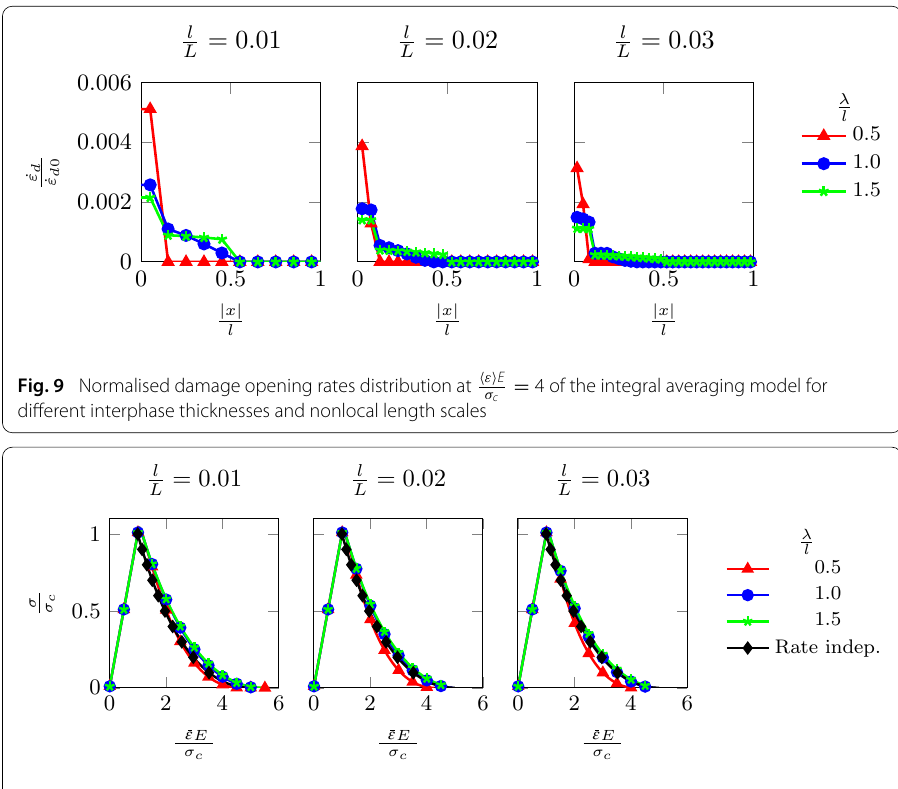
Fig. 10 The overall stress-strain response of the gradient damage model for different interphase band thicknesses and nonlocal length scales the applied average strain ¯ ε for all cases considered. Also shown (in black) is the underlying rate-independent response as given (analytically) by Eq. (12). For both types of nonlocality, and for all l / L shown, the computed stress-average strain responses for l / L = 1 . 0 and 1.5 practically coincide. They furthermore deviate only slightly from the analytical